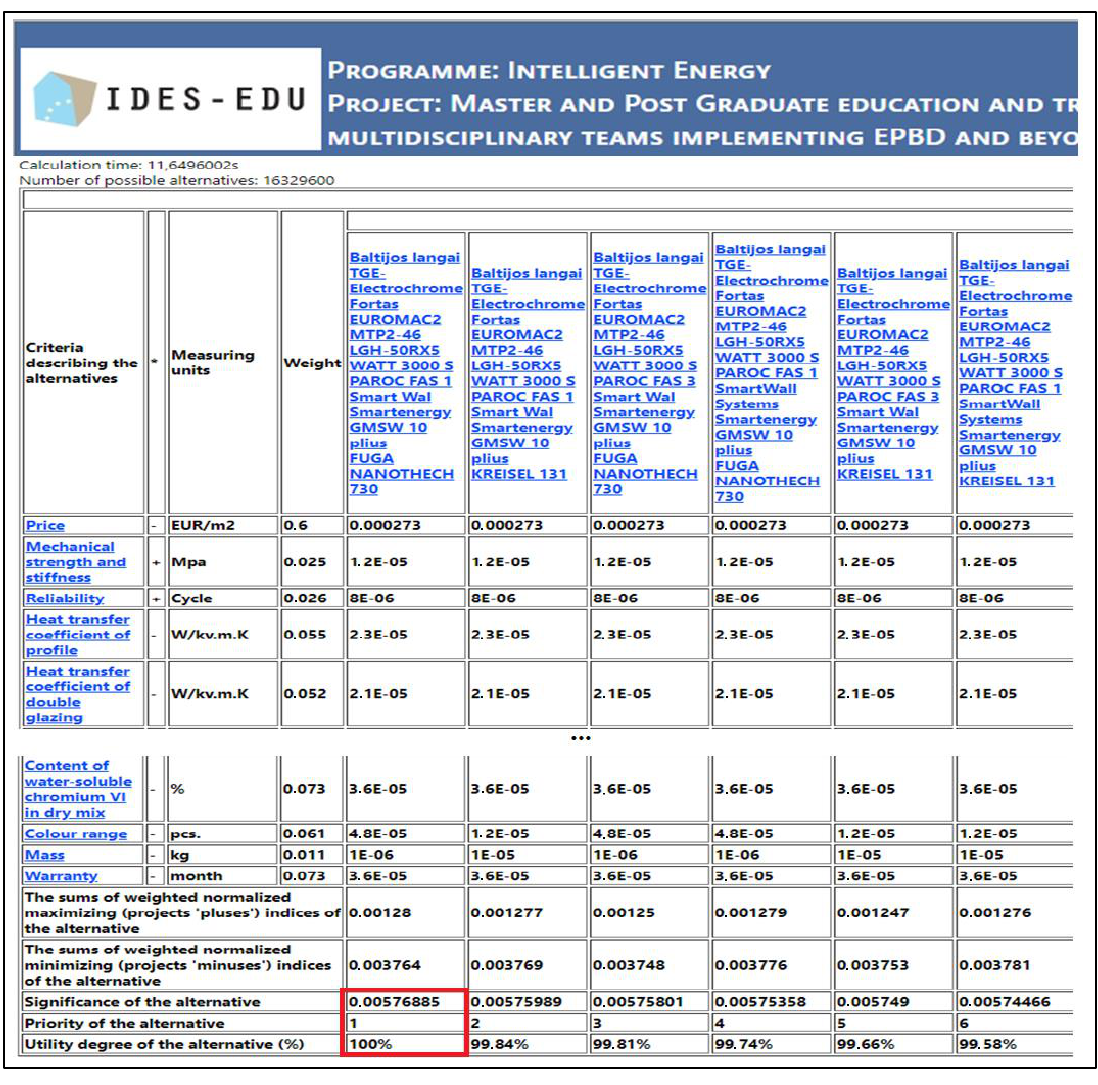
Figure 7. Development of the combinations of energy-efficient alternatives and their multiple criteria analysis (fragment).